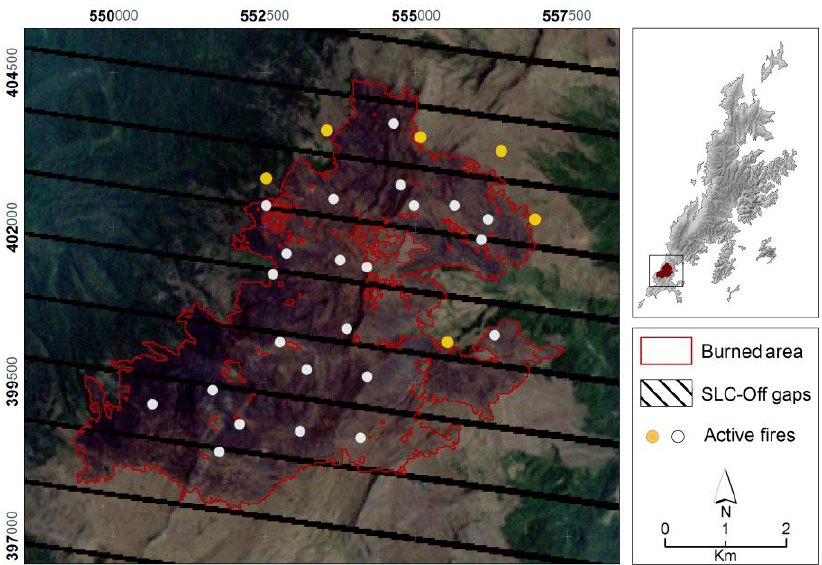
Figure 9. Landsat ETM+ (23 January 2007) showing a large fire scar (dark brown) and twenty-eight points representing FIRMS [44] active